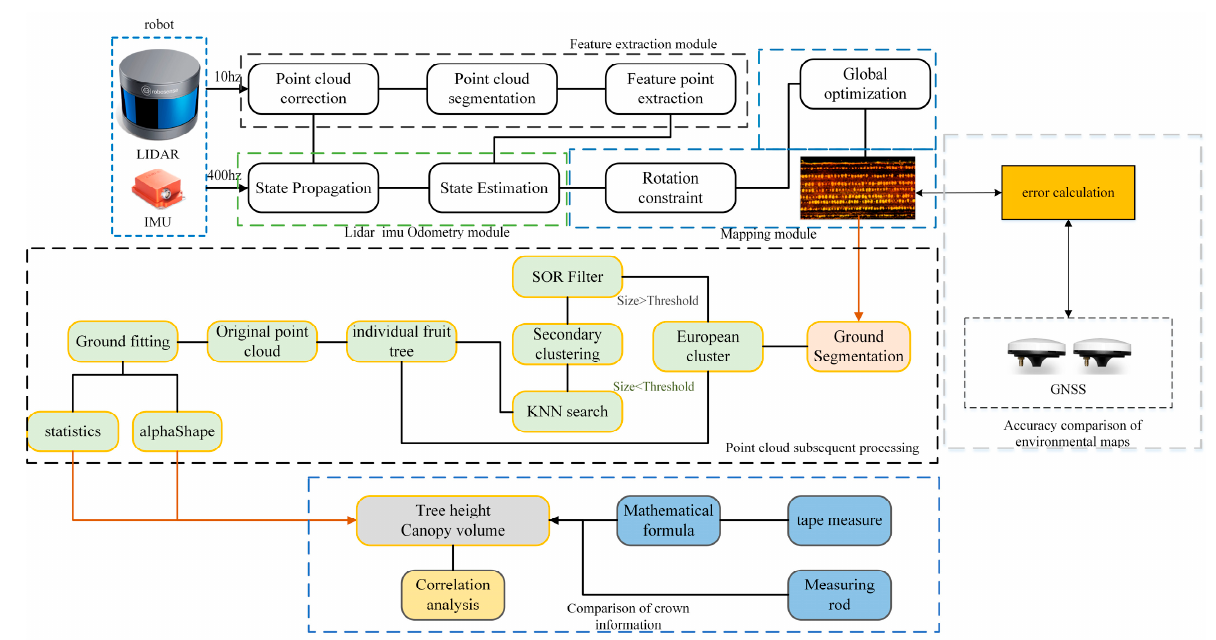
Figure 2. The framework of the software system: The top half of Figure 2 is the orchard environment reconstruction module, the middle part is the fruit tree canopy information measurement module, and the lower part and the right part are test modules.